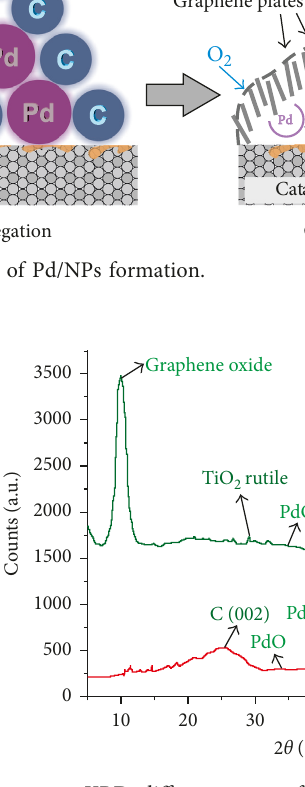
Figure 7: XRD diffractograms of the Pd/C target and of the